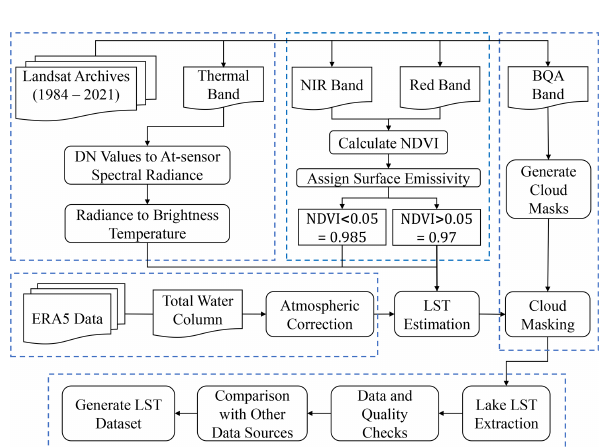
Figure 2. Workflow and methods for generating North Slave LST dataset from Landsat